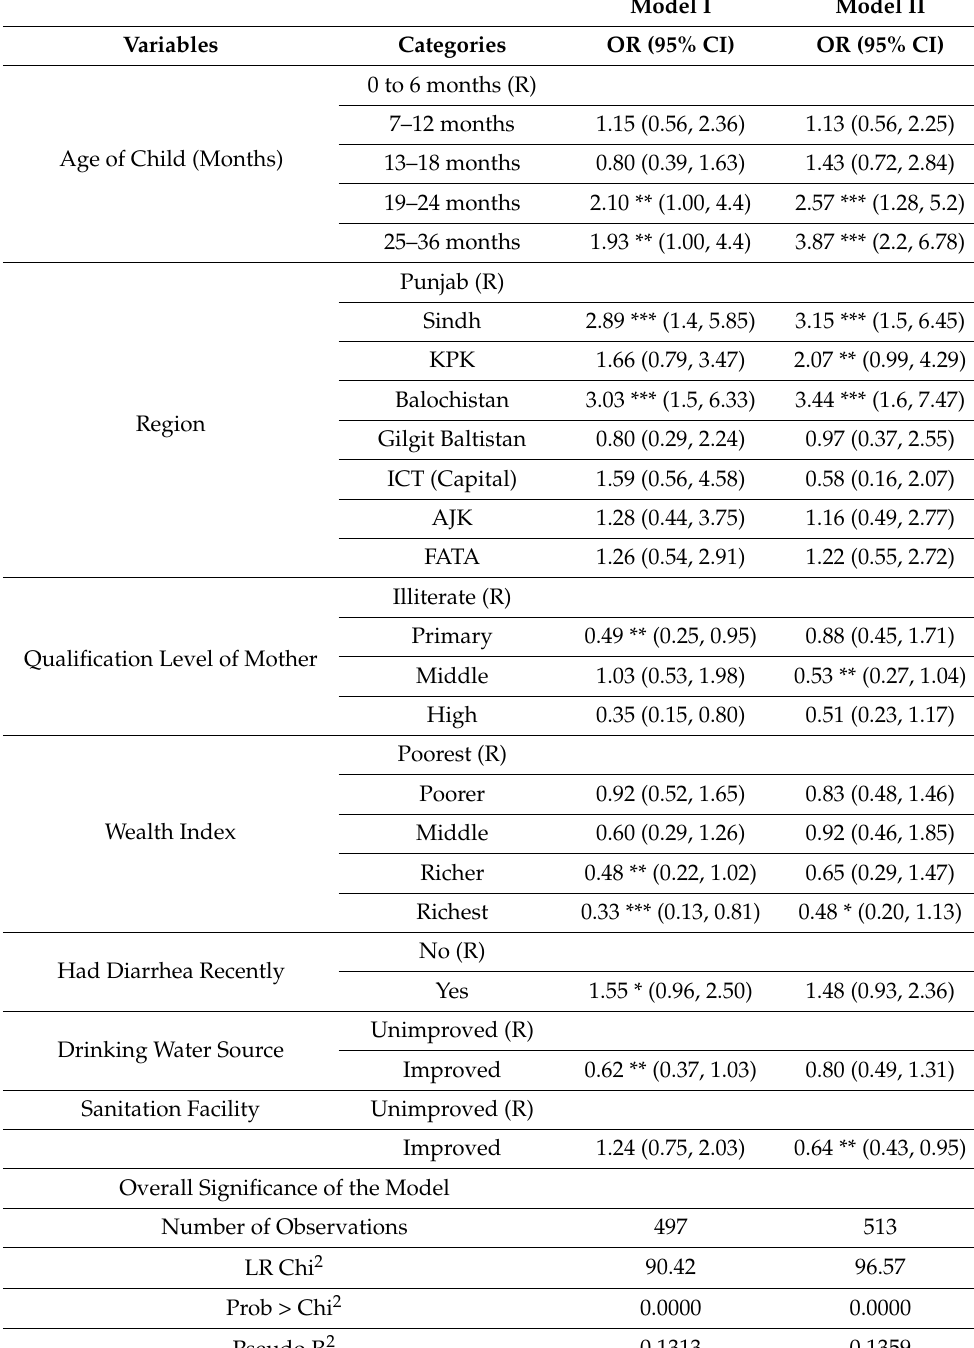
Table 3. Logistic regression showing adjusted odd ratios for the covariates of the